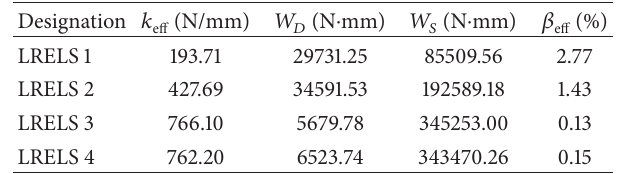
Table 6: Effective stiffness, damping, and energy dissipation in the out-of-plane horizontal direction.